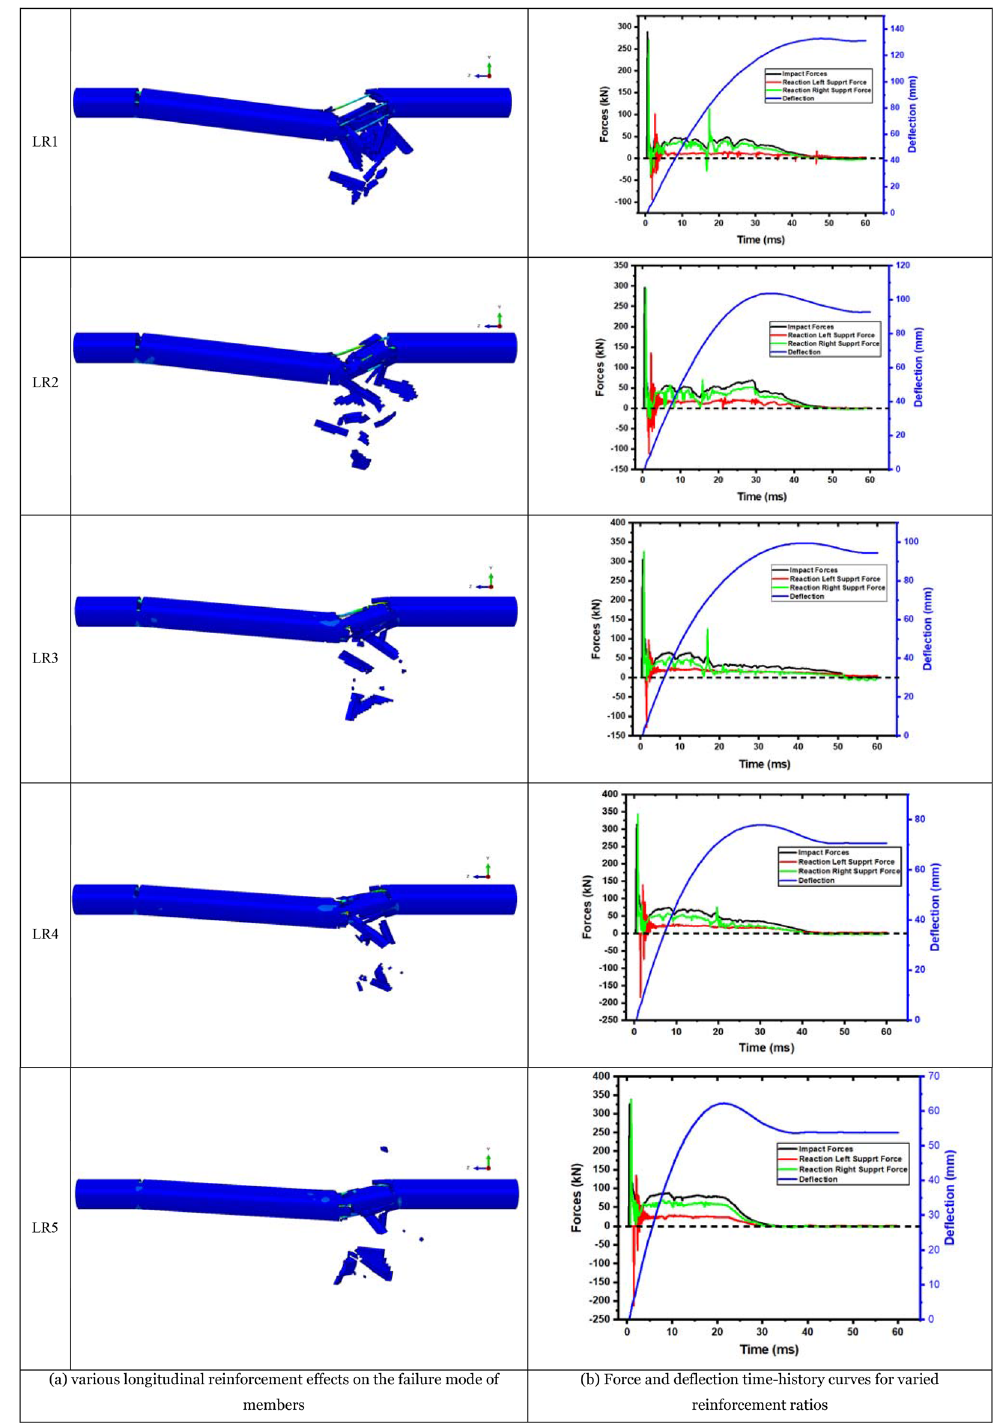
Figure 9. Force and deflection time-history curves with failure mode for varied reinforcement